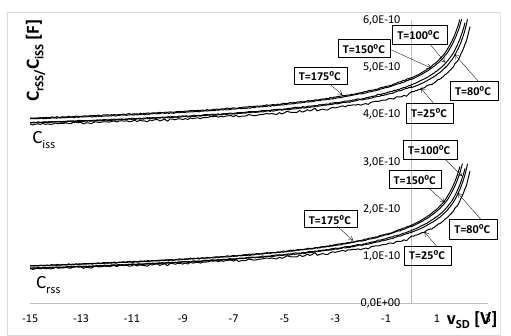
Fig.4. C iss (v SD ) and C rss (v SD ) characteristics of the 2N7635-GA transistor in a range of the ambient temperature from 25 ° C to 175 ⁰